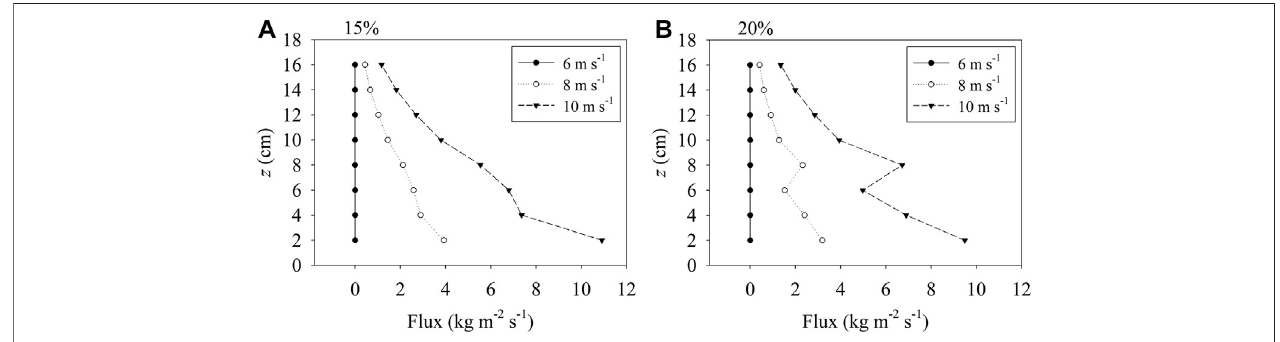
FIGURE12| Verticalpro fi lesofsand fl uxunderwindspeedsof6,8,and10 ms − 1 atgravelcoveragesof (A) 15and (B) 20%[modi fi